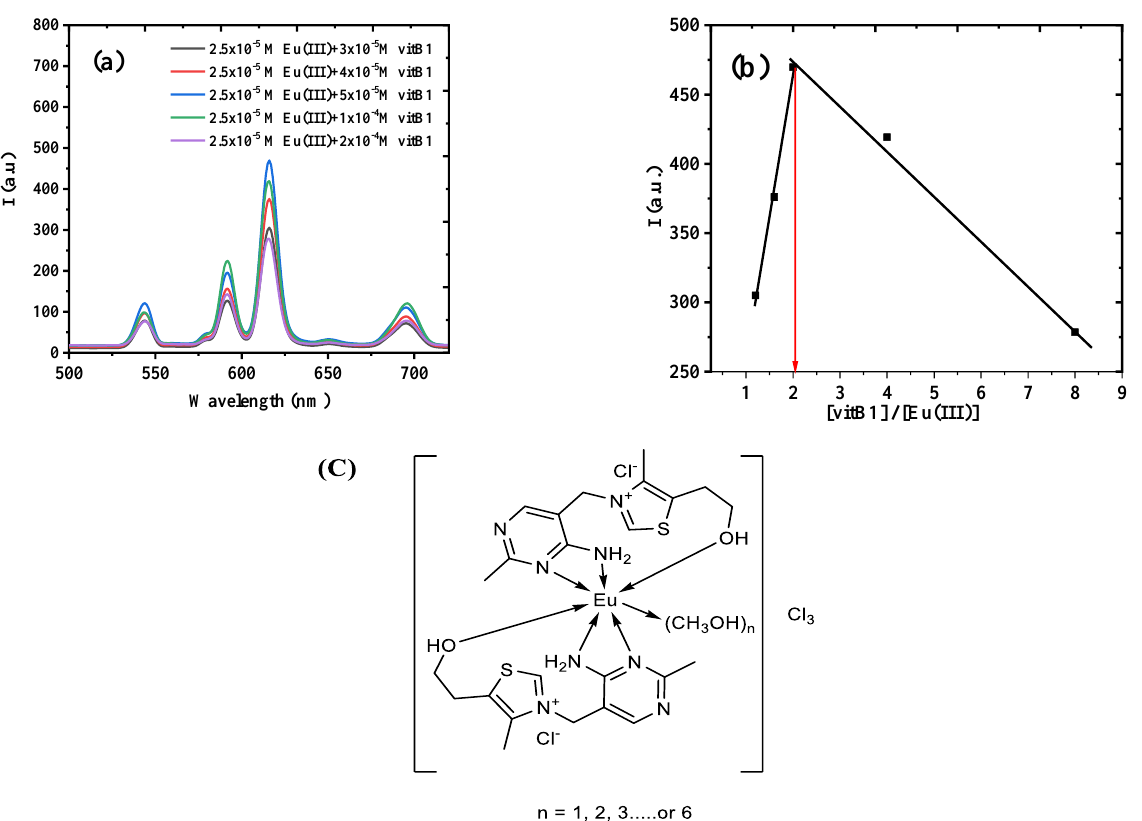
Figure 4. ( a ) The effect of vitB1 concentrations on the fluorescence of 2.5 × 10 −5 mol. L −1 Eu (III) in methanol at room temperature, λ ex = 268 nm. ( b ) The [vitB1]/[Eu (III)] mole ratio plot at λ em = 616 nm. ( c ) The hypothesized structure of the Eu (III) – (vitB1) 2 complex. VitB1 is a tridentate ligand which coordinates with the europium (III) ion